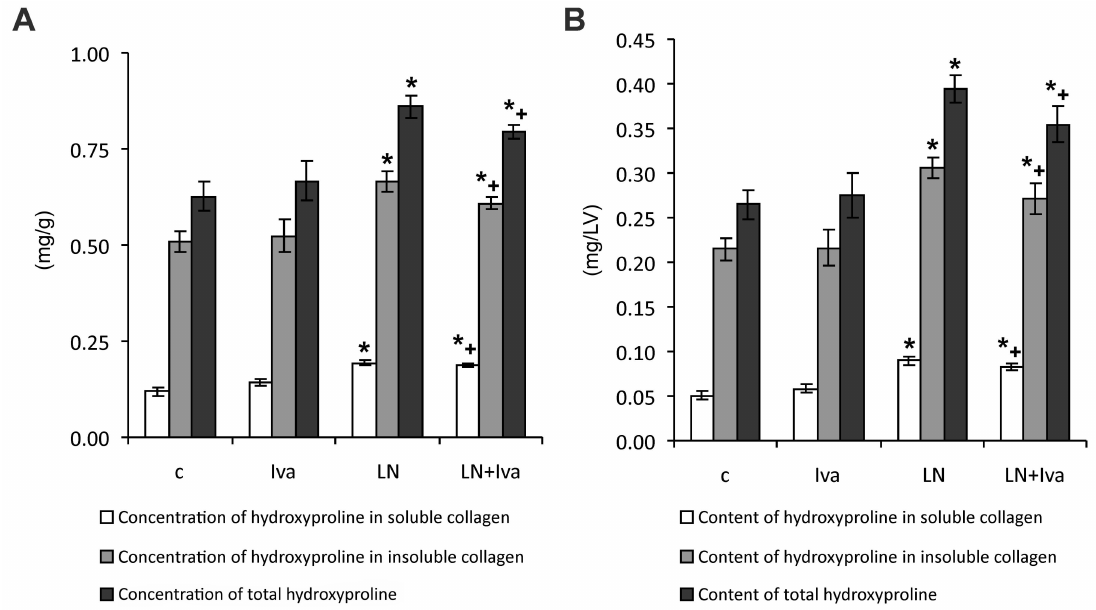
Figure 2. The influence of ivabradine (LN + Iva) on the hydroxyproline concentration in soluble and insoluble collagenous proteins and on the total hydroxyproline concentration ( A ) and content ( B ) in the left ventricle of L -NAME-treated rats. Wistar controls (c); L -NAME (LN); ivabradine (Iva); n = 10 per group; * p < 0.05 vs. c; + p < 0.05 vs. Iva; results are expressed as mean ±